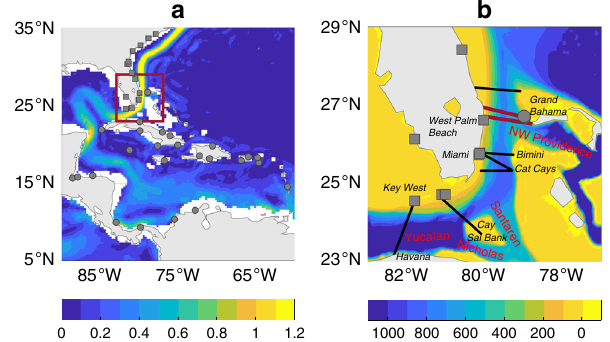
Fig. 1 Florida Current and study region. a Gray squares (circles) are locations of tide gauges in the southeastern USA (Caribbean). Shading is mean ocean surface current speed (m s − 1 ) from surface-drifter data 97 . Red box is area shown in b . b Details of Florida Straits. Shading is ocean depth (m). Red bold (black oblique) font indicates ocean channels (land locations) mentioned in the text. Thick red lines are locations of submarine- cable measurements 1 – 4 . Thin black lines are locations of in situ measurements from past studies 18 – 21